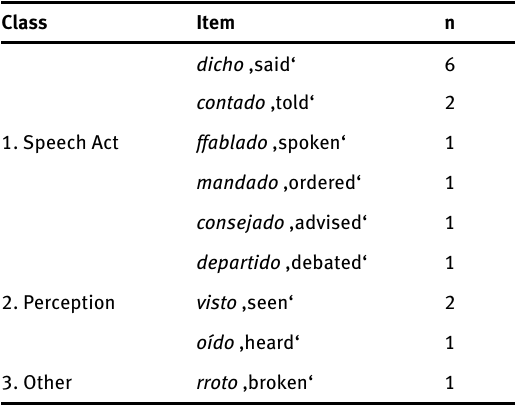
Table 1a. First occurrences of the PC quantified by ‘many times’ (13 th